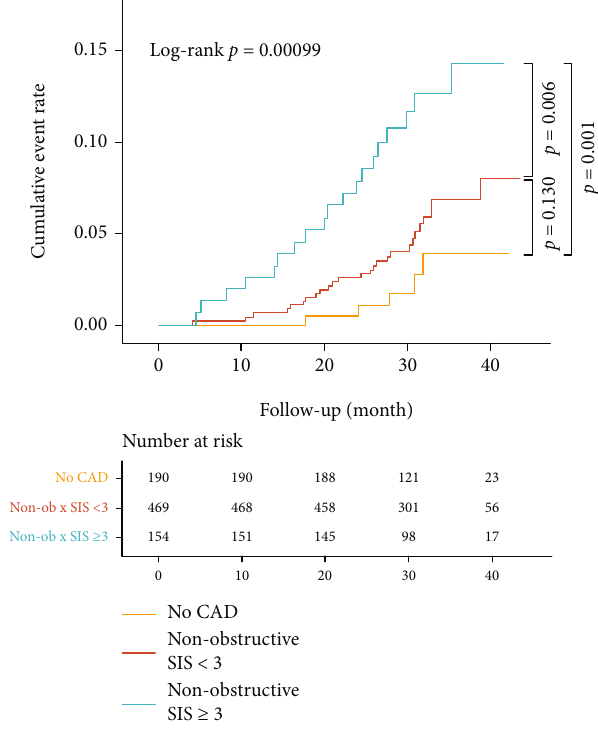
Figure 3: Cumulative risk of the composite endpoint on the basis of CAD severity with segment involvement score (no CAD, nonobstructive with SIS < 3 , and nonobstructive with SIS ≥ 3 ). CAD: coronary artery disease; SIS: segment involvement